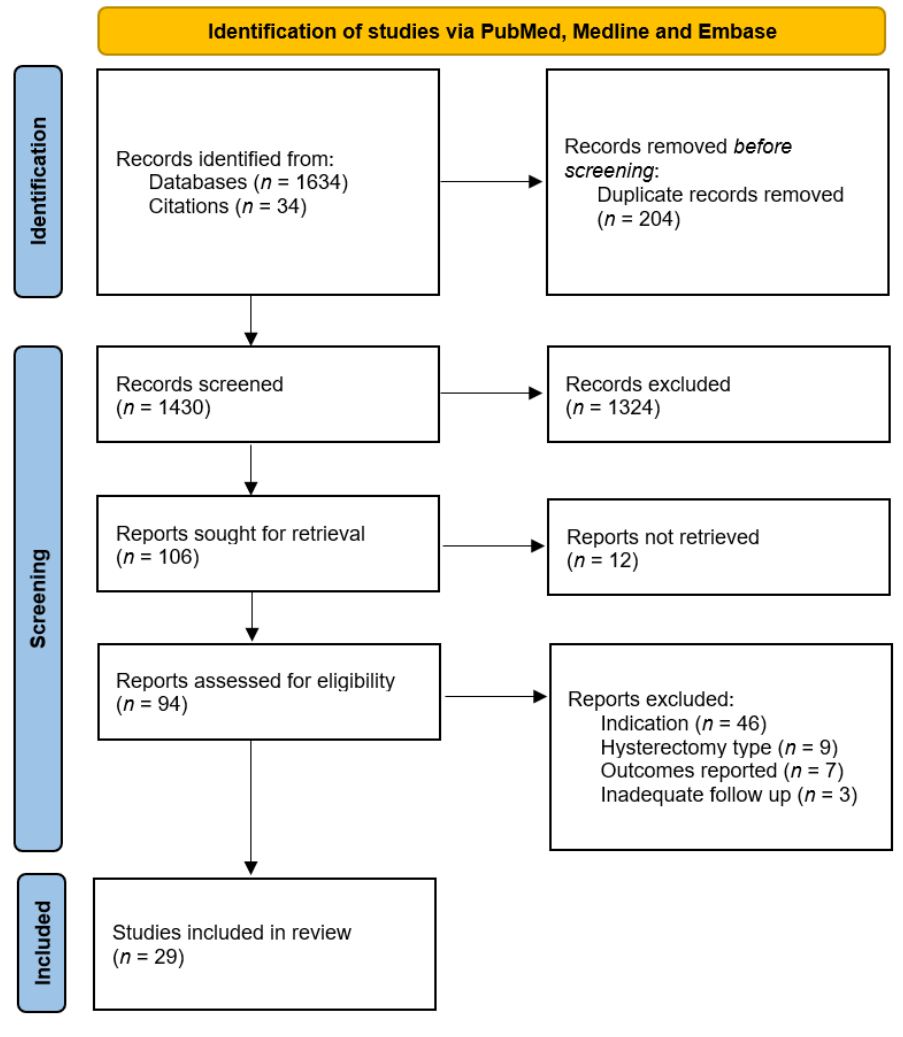
Figure 2. PRISMA flow diagram of study selection [30] .